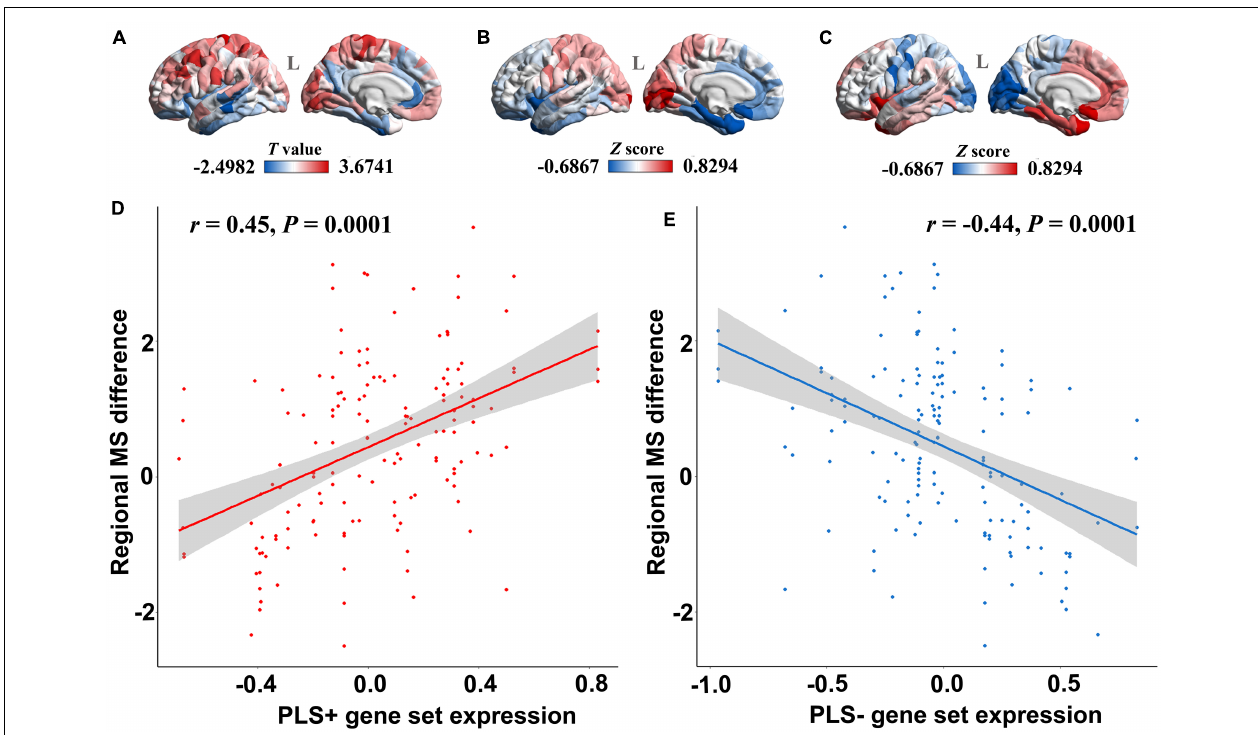
FIGURE 3 | The relationship between PLS1 gene set expression and regional morphometric similarity differences. (A) The regional morphometric similarity case-control T map in the left hemisphere. The regions in red indicate increased morphometric similarity in AD, whereas the blue color indicates decreased morphometric similarity in AD. (B) The PLS1 + gene set expression map illustrates that regions in red have increased expression of the PLS1 + gene set, whereas regions in blue have decreased expression of the PLS1 + gene set. (C) The PLS1- gene set expression map illustrates that regions in red have increased expression of the PLS1- gene set, whereas regions in blue have decreased expression of the PLS1- gene set. (D) The point plot in red shows that the expression of the PLS1 + gene set is significantly positively correlated with the regional morphometric similarity difference between AD patients and healthy elderly individuals. (E) The blue point plot shows that the expression of the PLS1- gene set is significantly negatively correlated with regional morphometric similarity differences between AD patients and healthy elderly